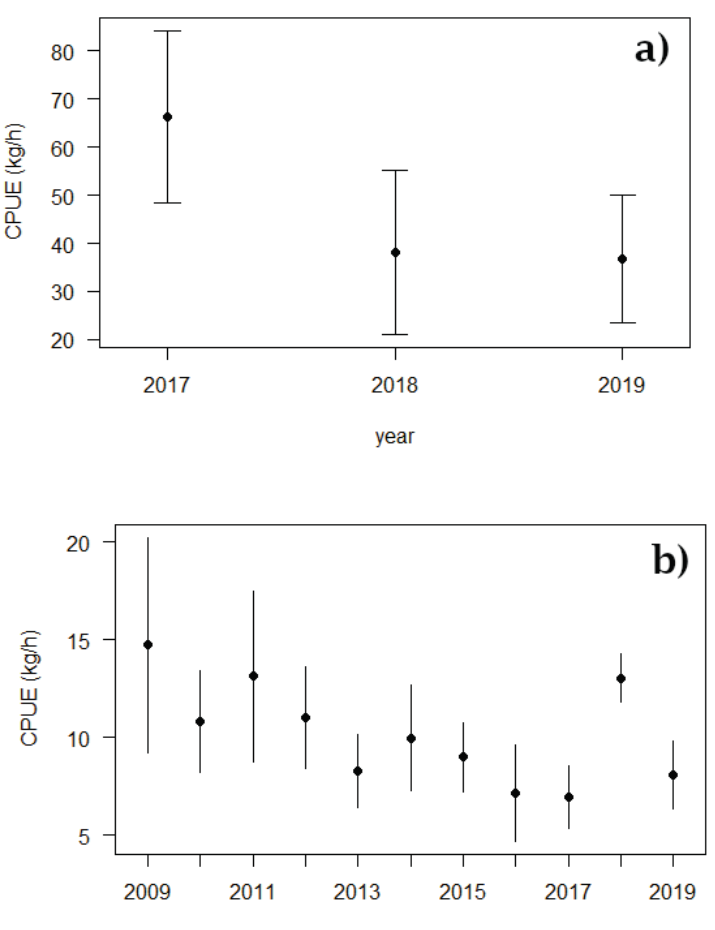
Figure 4. Graphs with the annual means and standard error of CPUE in the harvest months. a) shows data from Paraná and b) data from São